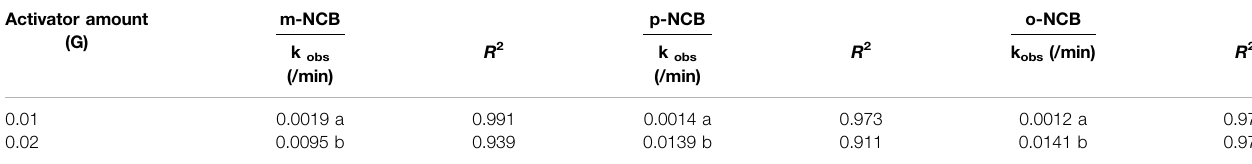
TABLE 1 | Kinetics constants for aqueous OCPs degradation by varied ZVI systems.